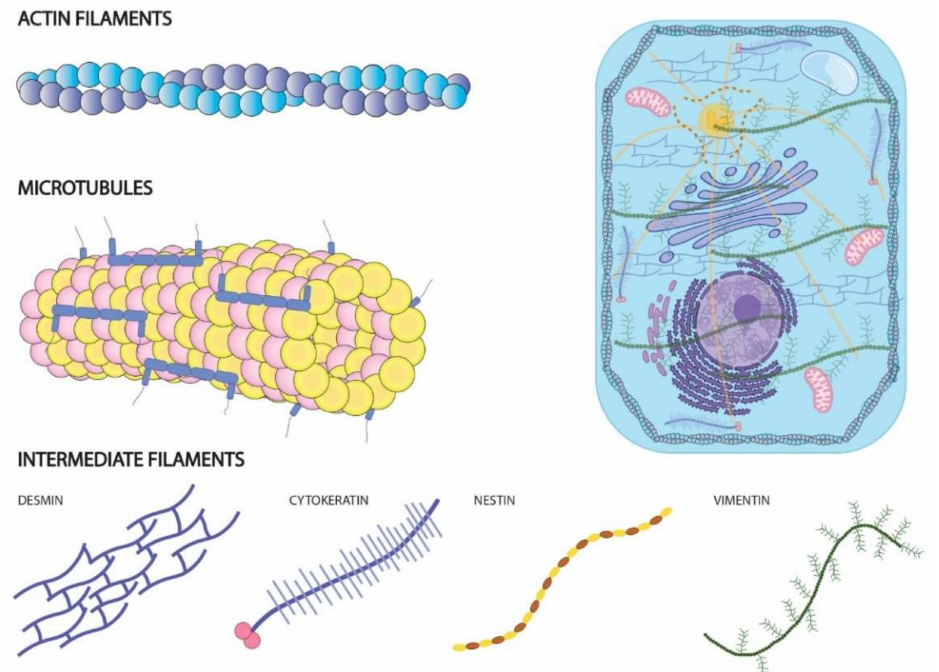
Figure 1. Schematic representation of three main cytoskeletal protein structures. Actin filaments are responsible for shape and movement of cells; Microtubules’ function is essential for cell cycle progression; intermediate filaments exert a structural function in cytoskeletal